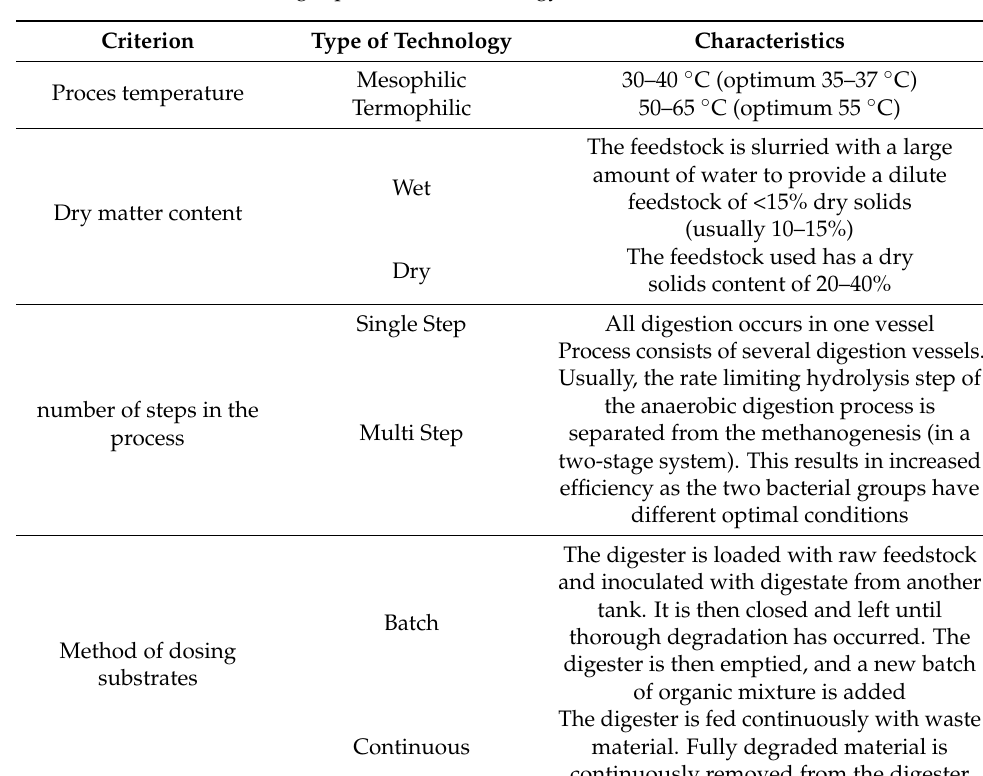
Figure 6. Anaerobic digestion process and reactions. Table 5. Classification of biogas production technology.